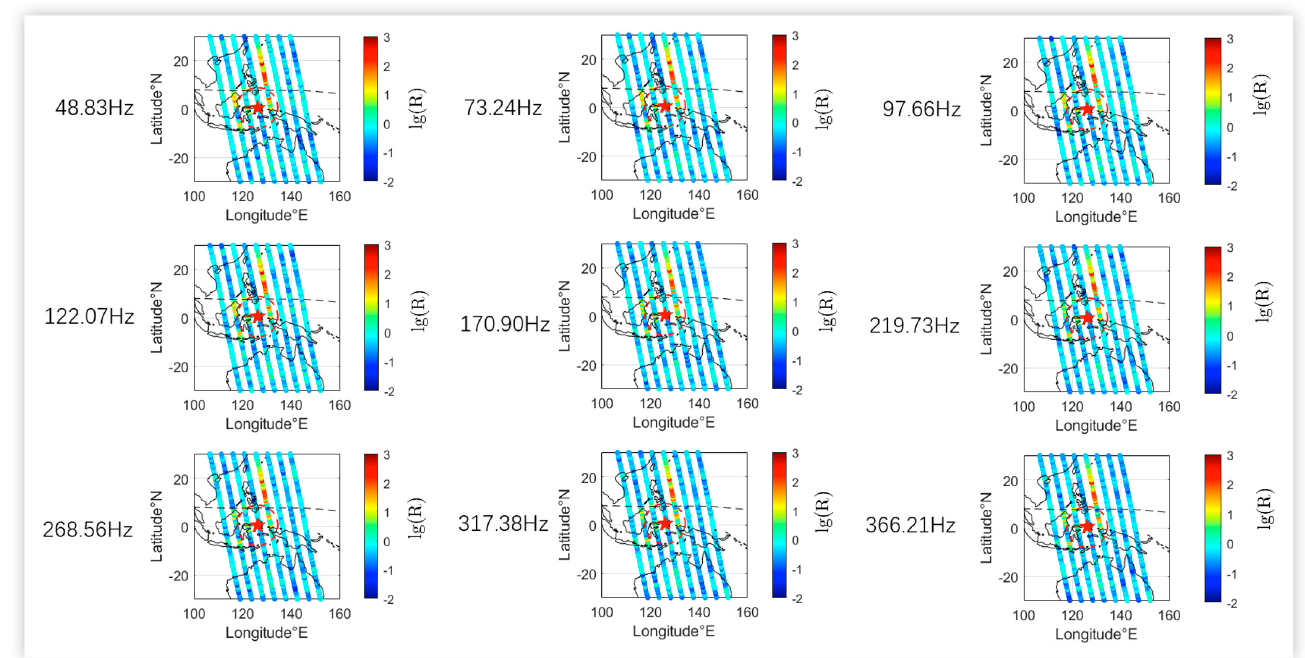
Figure 4. Using the earthquake No. 1 as the object, the relative values of the electric field PSD on ascending orbits from 4 July to 8 July. From left to right, the dotted lines indicate the satellite trajectories on 8, 4, 5, 6, 7, 8, 4, and 5 July, respectively. The red stars, dashed circles and black dashed curves indicate the epicenters of two earthquakes, the estimated seismogenic zones and the magnetic equators, respectively.